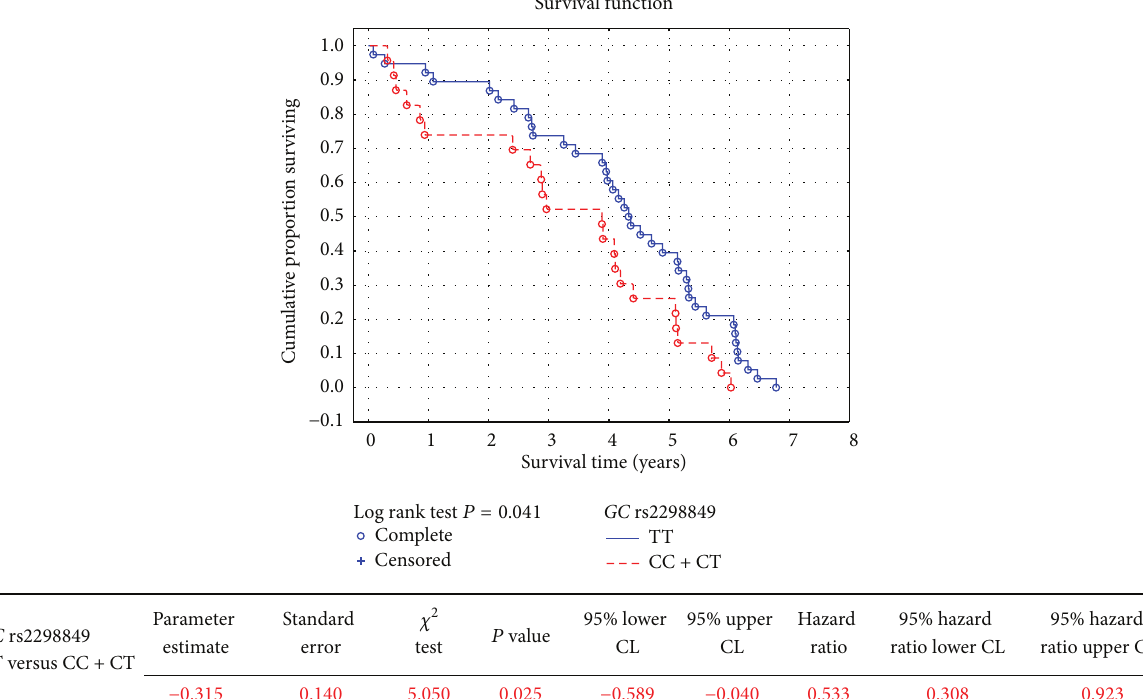
Figure 2: Infection-related and neoplasm-related mortality in hemodialysis patients in respect to GC rs2298849 polymorphic variant.